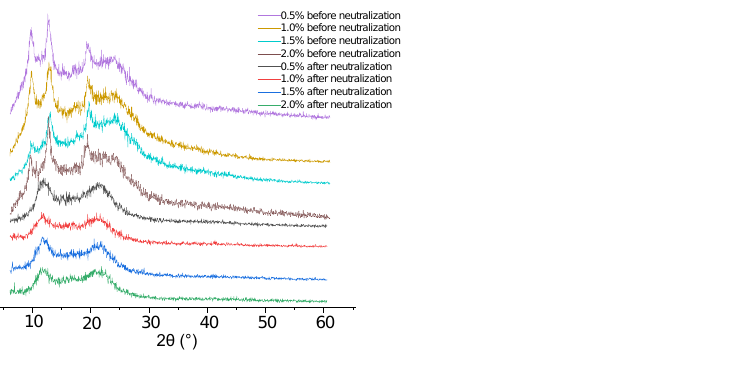
Figure 6. Effects of chitosan concentration on XRD diffractograms of chitosan films before and after neutralization.